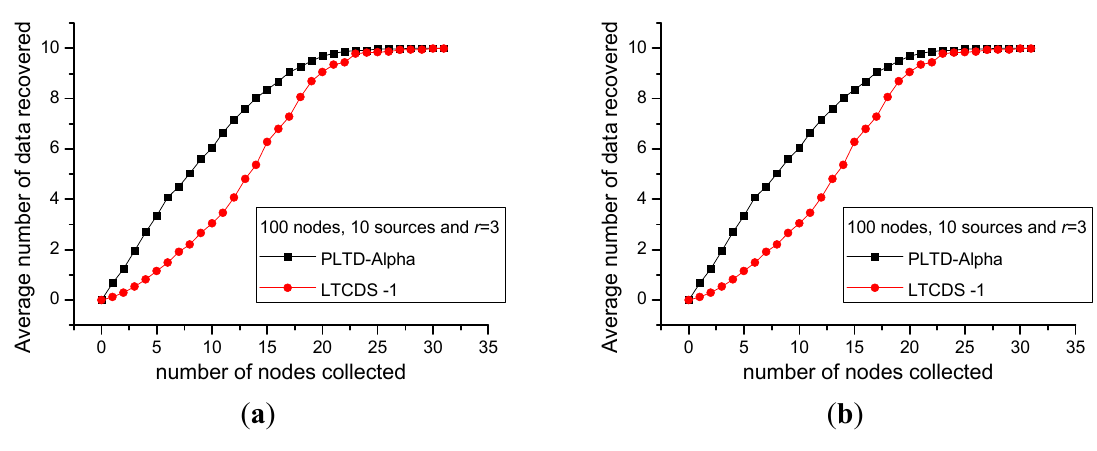
Figure 10. Data recovery performance in small scale WSN system. ( a ) n = 100, k = 10 ( b ) n = 100, k = 20.